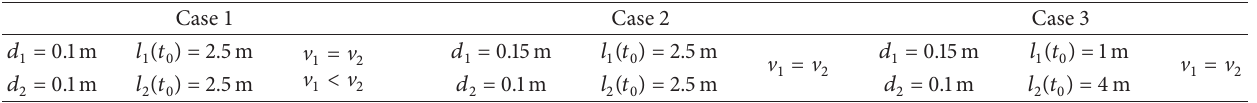
Table 1: Three models of